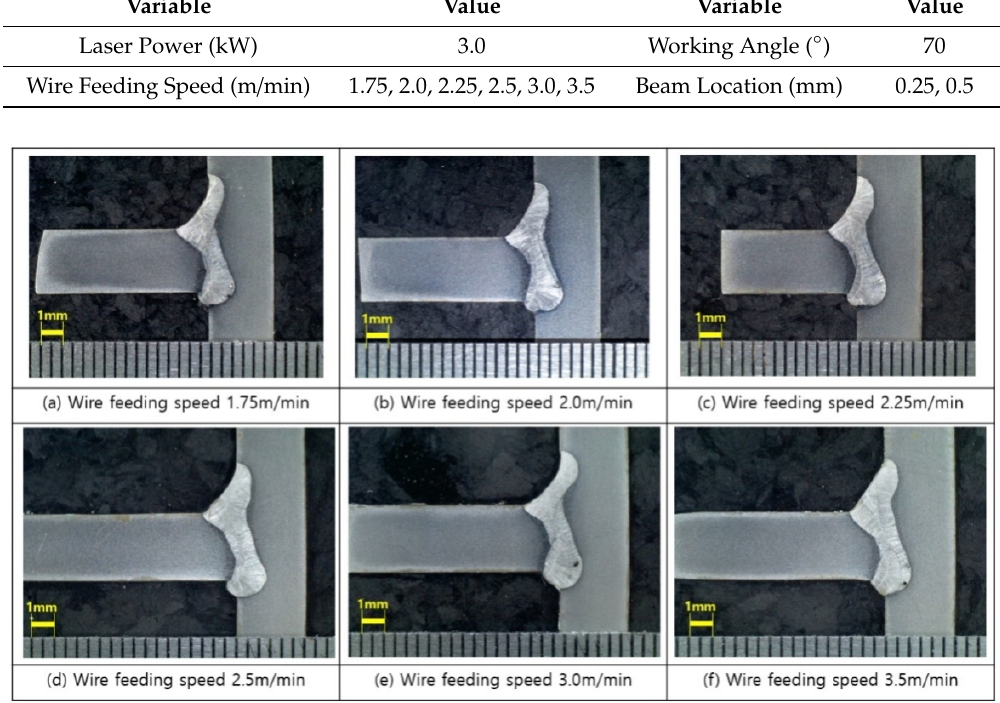
Figure 14. Di ff erent wire feeding speeds with 0.25 mm beam location. Figure 14. Different wire feeding speeds with 0.25 mm beam location. Figure 14. Different wire feeding speeds with 0.25 mm beam location.